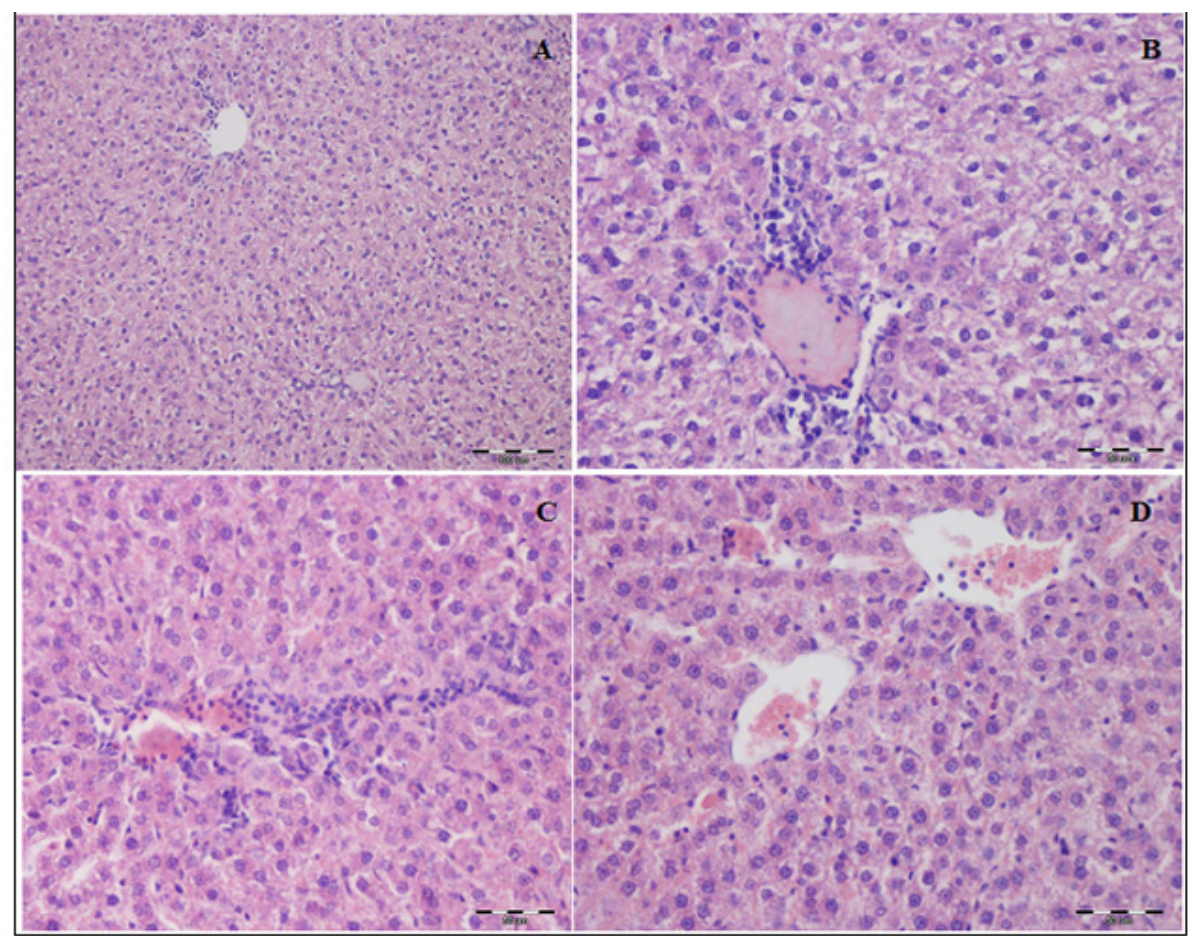
FIGURE 5 - Representative photomicrographs of liver sections from (A) normal control group showing normal liver architecture (H&E × 200); (B) APAP-treated group showing hepatocyte degeneration, necrosis, congestion, and inflammatory cells infiltrations in periportal area (H&E × 400); (C) sitagliptin-treated group (10 mg/kg/day for 5 days before APAP administration) showing mild congestion and hepatocyte degeneration at periportal area (H&E × 400); (D) N -acetylcysteine-treated group (100 mg/kg orally) showing amelioration of liver alterations with mild congestion and inflammatory infiltrates (H&E ×